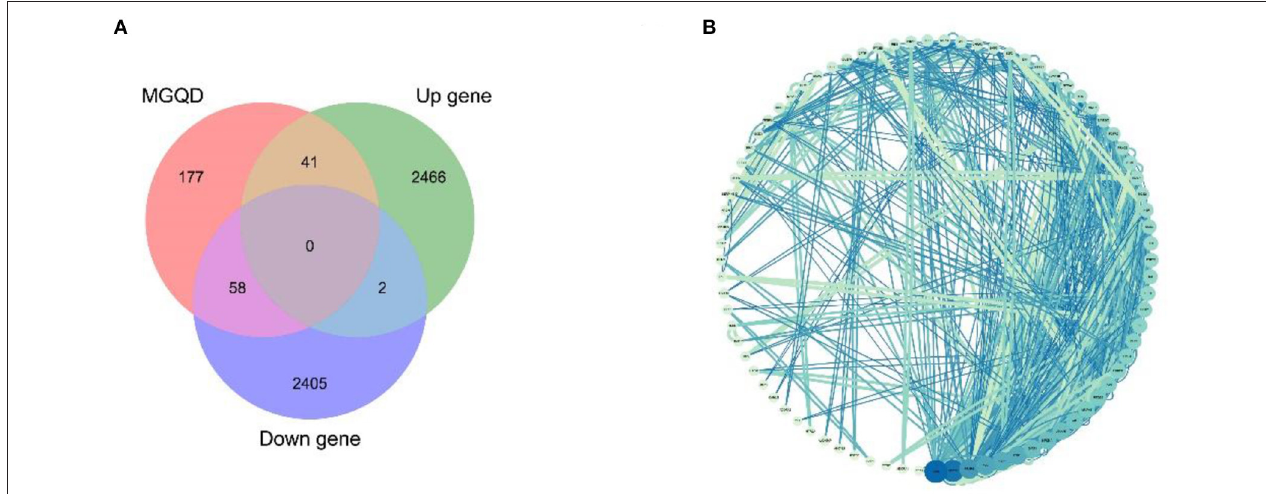
FIGURE 2 | Drug target protein-chicken coccidioidomycosis differential protein interaction (PPI) network construction. (A) Number of potential targets of MGQD against coccidiosis in chickens. MGQD, database of the target sites of MGQD; Up gene, Up-regulated genes in transcriptome analysis of cecum tissue of chickens infected with Eimeria tenella ; Down gene, Down-regulated genes in transcriptome analysis of cecum tissue of chickens infected with Eimeria tenella . (B) Potential target interactions of MGQD against chicken coccidiosis. The circle represents the intersection of MGQD and CC target proteins, the larger the diameter of the circle the darker the color, representing the greater the degree value. The line represents the interaction relationship between target proteins, the thicker the line the darker the color, indicating the stronger the interaction between target proteins.